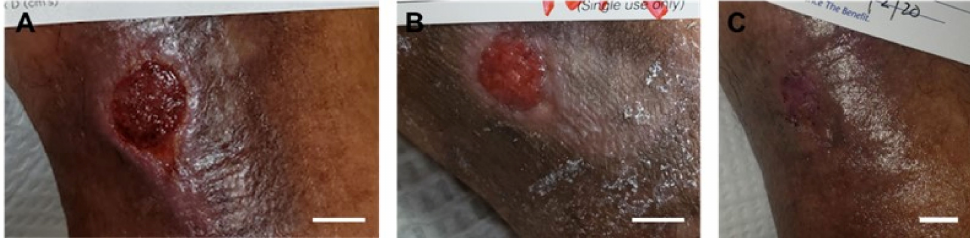
Figure 5. Treatment of a representative 5-year venous leg ulcer using the synthetic hybrid-scale fiber matrix. ( A ) Week 0, ( B ) week 5, and ( C ) complete healing at week 24. Scale bars represent 1